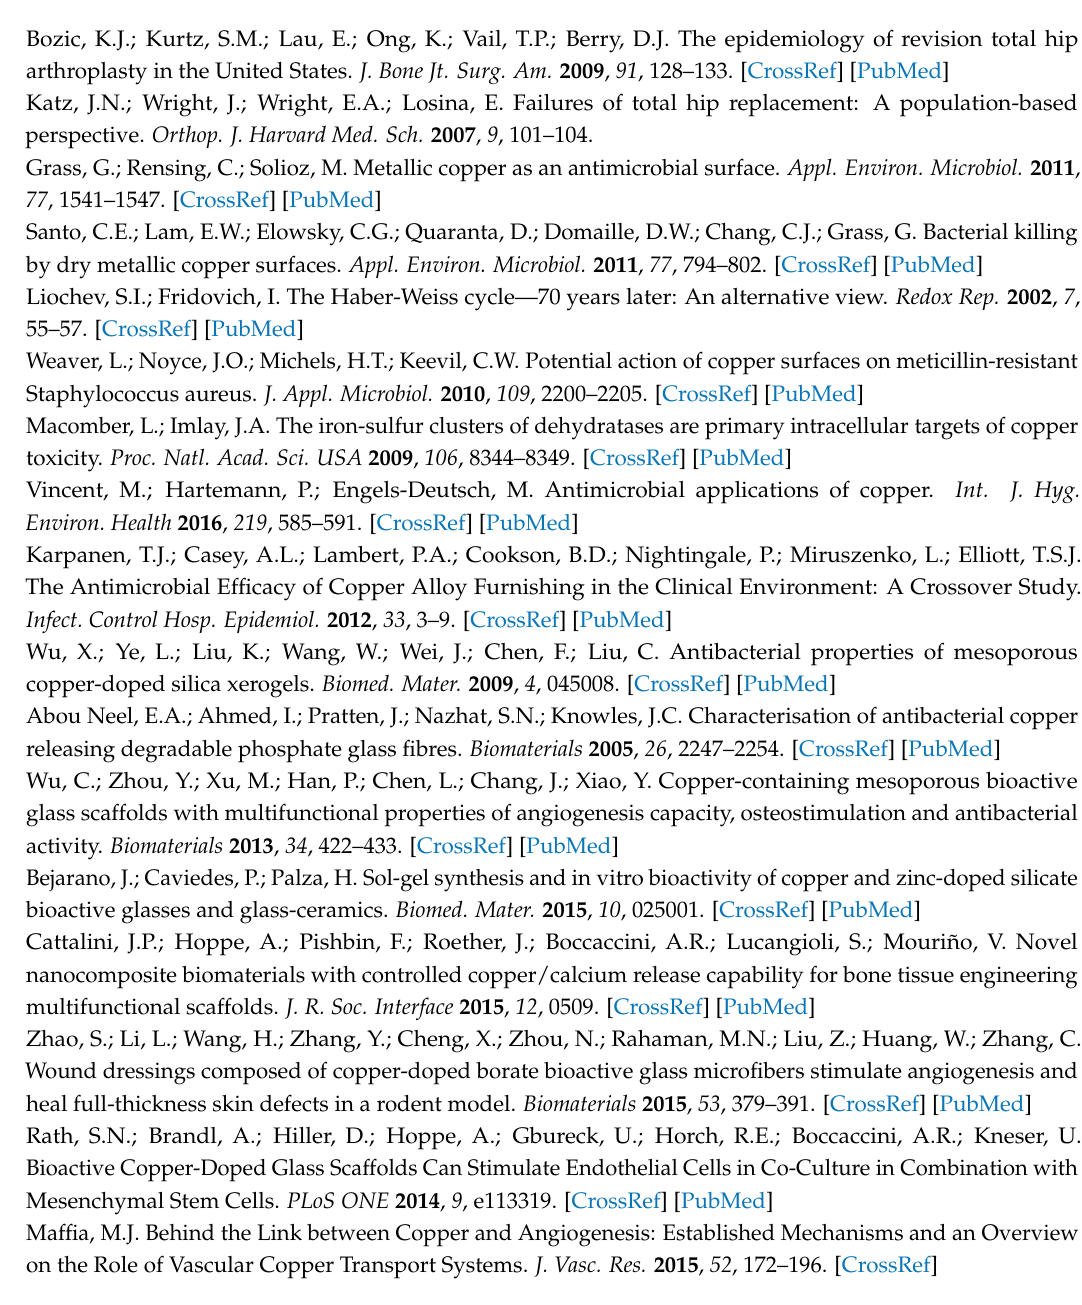
Table S1: S. epidermidis broth dilution susceptibility test results. Susceptibility pattern was expressed as follow: S: Susceptible, I: Intermediate, R: Resistant. MIC represents minimal inhibitory